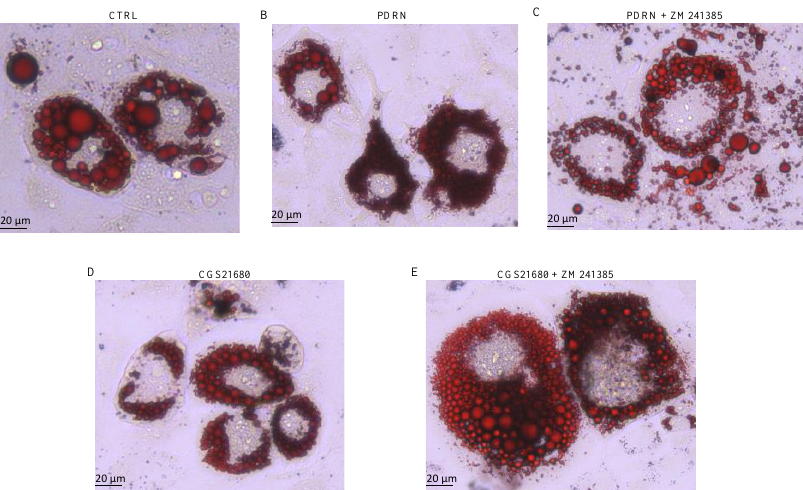
Figure 2. The panel shows differentiated adipocytes stained by Oil Red O staining of CTRL ( A ), PDRN ( B ), PDRN + ZM241385 ( C ), CGS21680 ( D ) and CGS21680 + ZM241385 ( E ). Scale bar 20 µm.